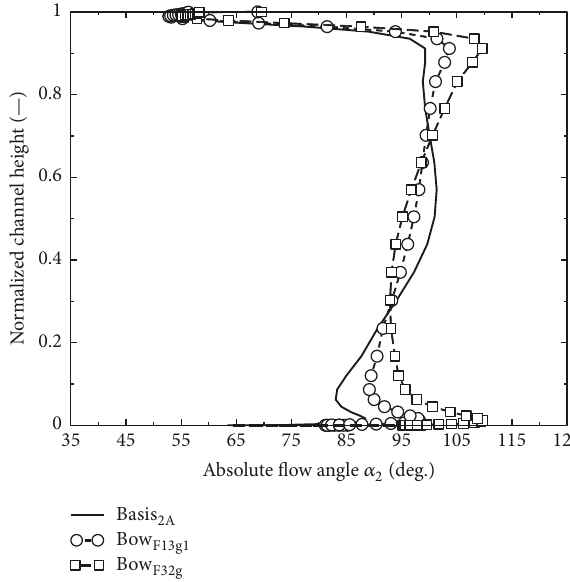
Figure 16: Circumference averaged absolute exit flow angle 𝛼 2 over the channel height in position 2